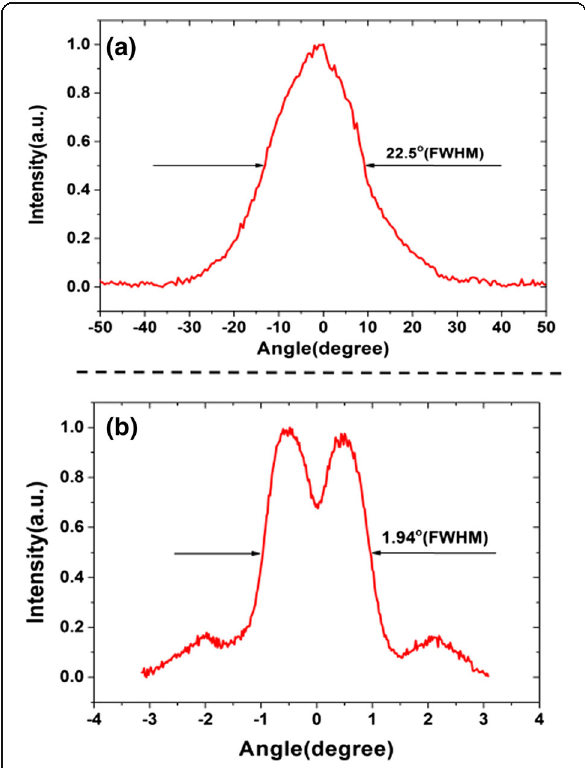
Fig. 4 The far-field distribution of a 0.5-mm cavity-length device. a , b The far-field distributions in the ridge-width and cavity-length direction,